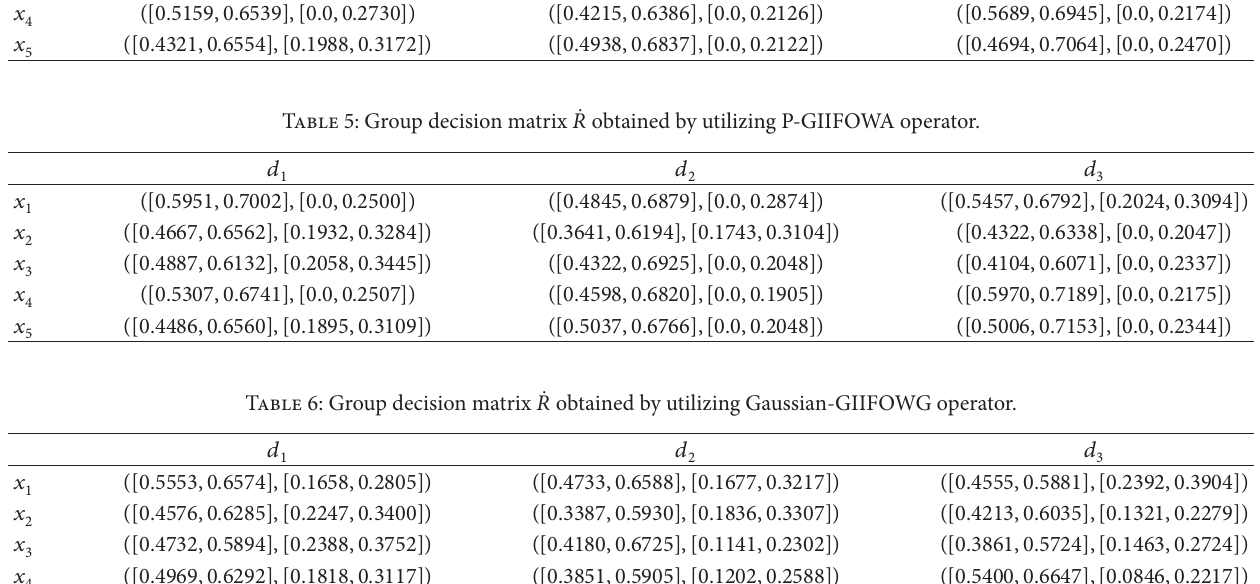
Table 5: Group decision matrix